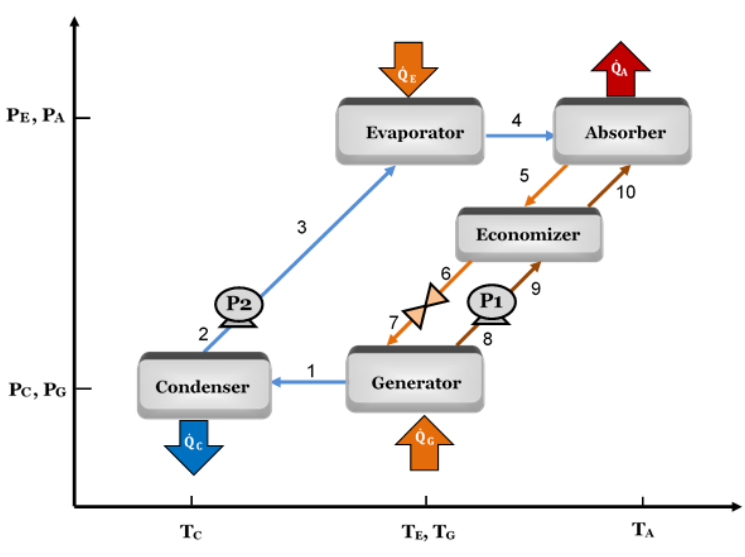
Figure 1. Temperature and pressure levels of a single-stage heat transformer (SSHT).